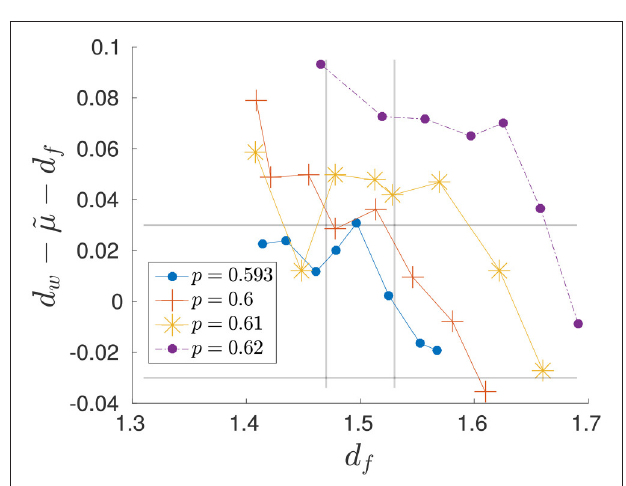
FIGURE 6 | Deviation from the Einstein relation. Vertical lines represent Tulum’s karst networks fractal dimension, given the confidence interval. Horizontal lines are confidence interval given exponents ( d f , d w , and ˜ µ ) computed on Tulum’s karst networks ( Table 1 ).